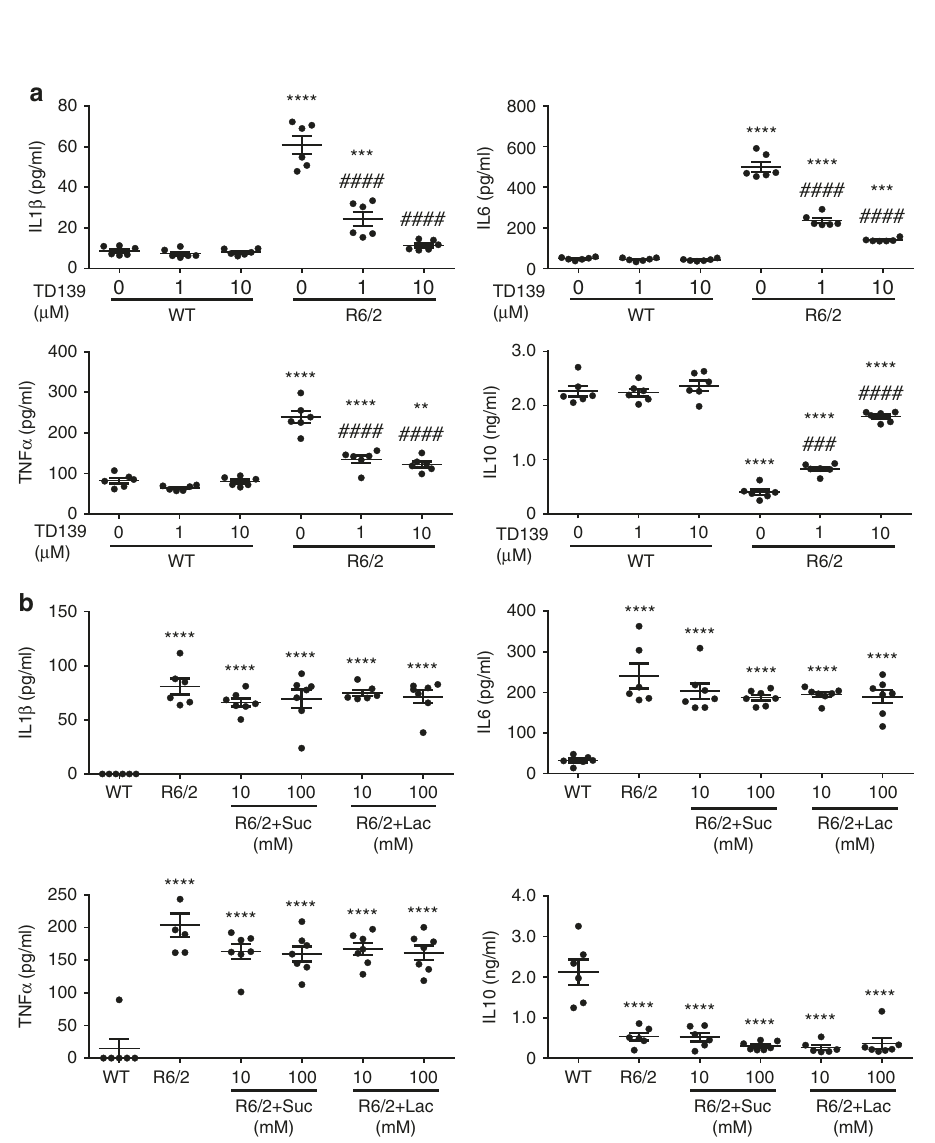
Fig. 5 Inhibition of Gal3 by TD139 intracellularly suppresses microglial in fl ammation. a Primary microglia were cultured for 24 h and then treated with a cell-permeable Gal3 inhibitor, TD139 (1 and 10 µ M), or vehicle (0.1% DMSO) for 48 h, and the supernatants were then collected for measurement of IL1 β , IL6, TNF α , and IL10 levels using ELISA ( n = 6). b Primary microglia were treated with lactose (10 and 100 mM) to block the binding of extracellular Gal3. Sucrose served as the osmolarity control. The supernatant was collected and subjected to ELISA ( n = 6 – 7). Suc sucrose, Lac lactose. The results of a were analyzed by two-way ANOVA followed by Tukey ’ s post hoc test. *Speci fi c comparison between WT and R6/2 cells of the same treatment; #Speci fi c comparison between the DMSO-treated and TD139-treated groups of the same genotype; P < 0.01. Results in b were analyzed by one-way ANOVA followed by Tukey ’ s post hoc test. *Speci fi c comparison between WT and R6/2 cells; #Speci fi c comparison between R6/2 cells treated with Lac and Suc. Data are presented as the means ± SEM from the indicated sets of cells. ** P < 0.01, *** P < 0.001, **** P < 0.0001. Same P -value denotation for #.